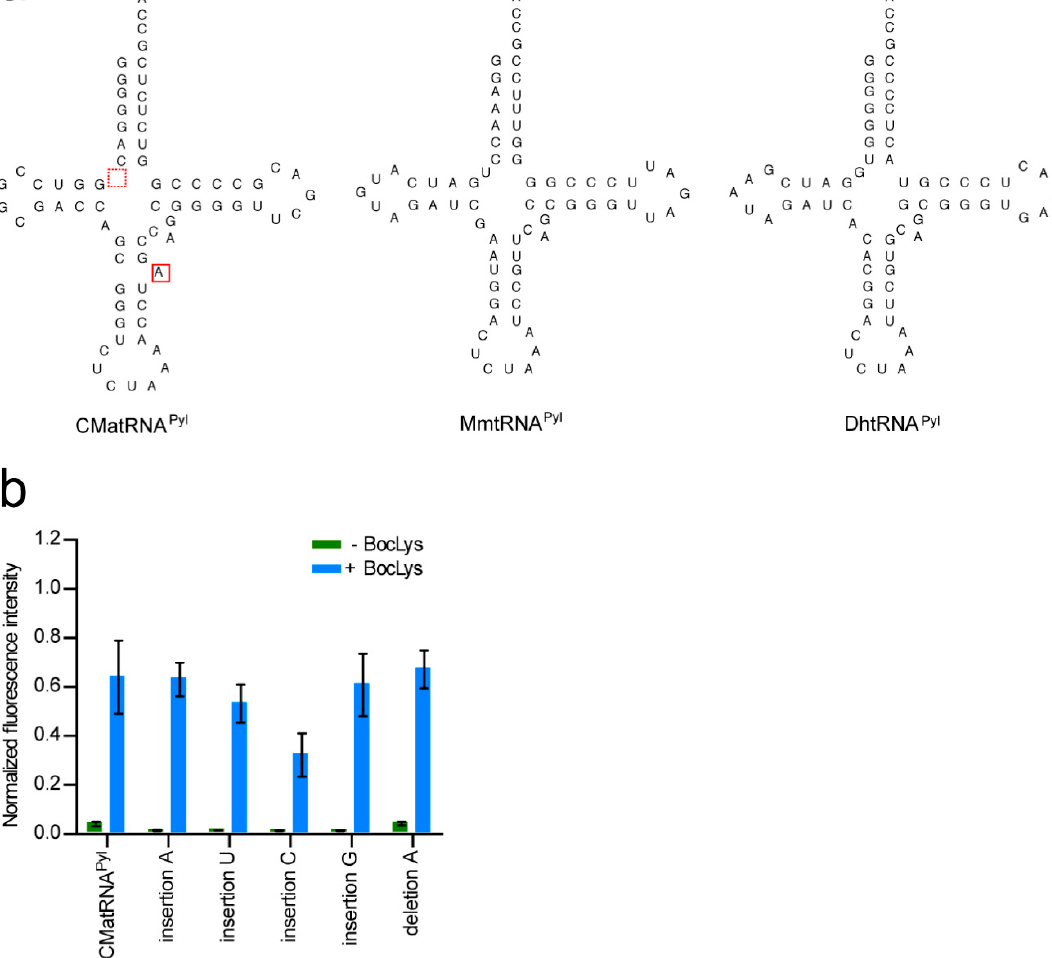
Figure 4. ( a ) CMa tRNA Pyl , Mm tRNA Pyl , and Dh tRNA Pyl in the cloverleaf representation. ( b ) The intensity of the cell-based fluorescence was indicated for each of the modifications to CMa tRNA Pyl relative to that of the fluorescence from the GST-GFP with no in-frame UAG. Three independent experiments were performed. The error bars indicate standard deviations.